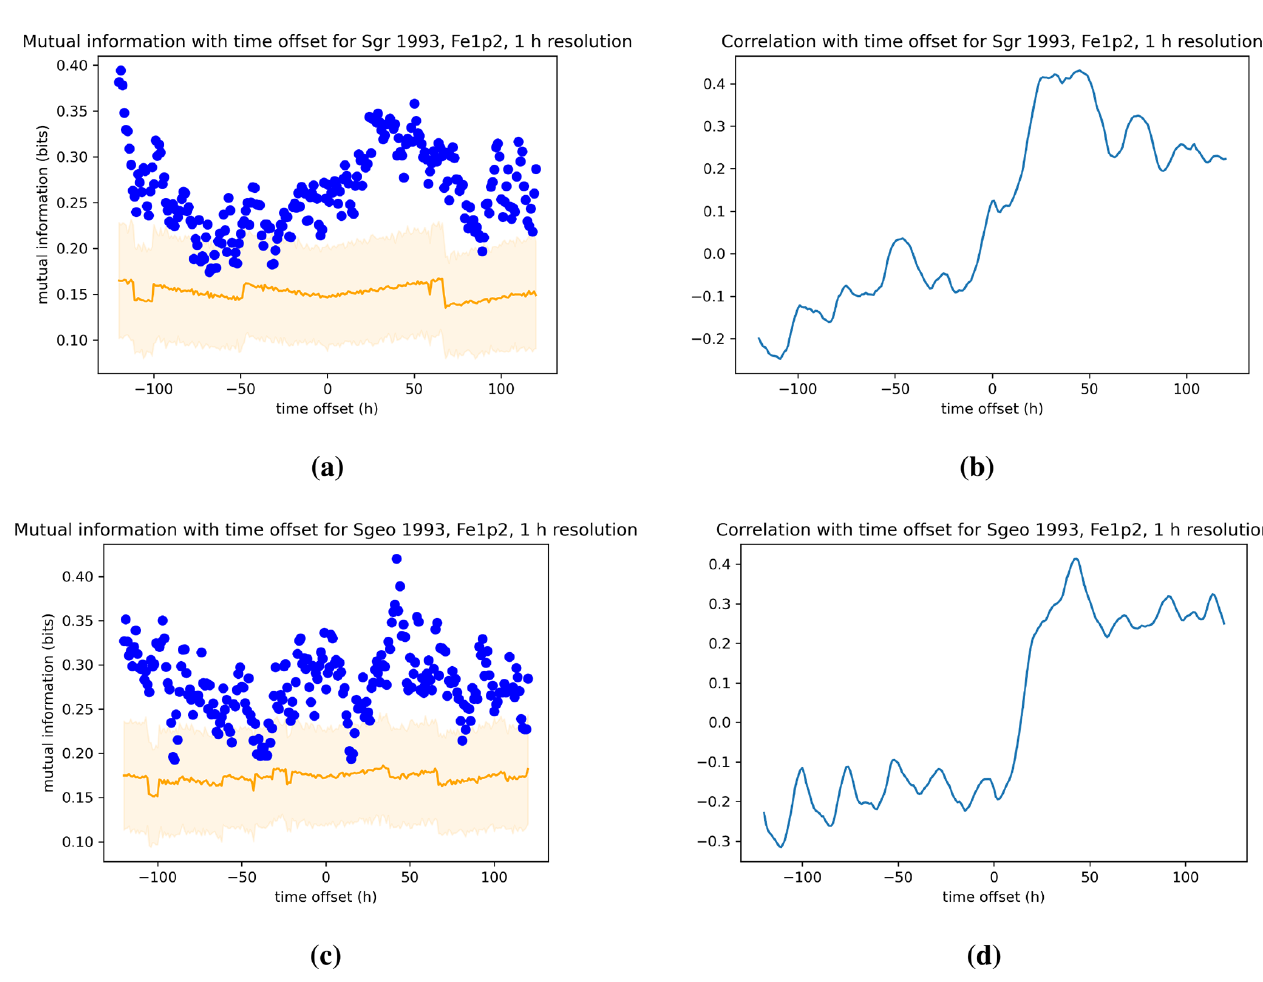
Figure 6. Same as in Fig. 4 but for the 1993 event of Rostoker et al. (1998).